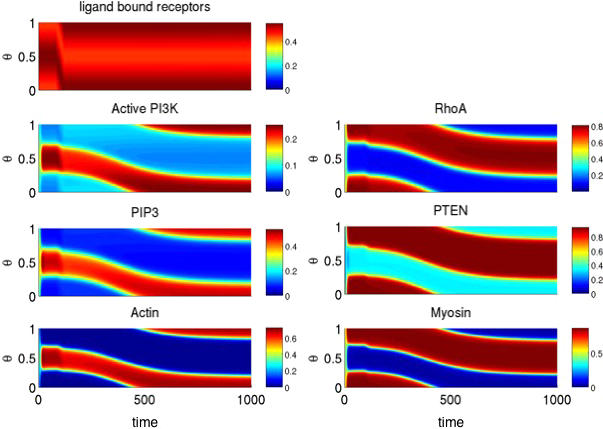
Separation of Front and Back Molecules in Response to a 50% Gradient of ChemoattractantSpatial and temporal distribution of the front (left) and back (right) signaling molecules. The abscissa is time (dimensionless), the ordinate θ, taking values between zero and one, is the position on the membrane, and the color intensity denotes the concentration. Chemoattractant concentration on the surface of the cell was specified by the function L(θ) = 1 − 0.25 cos(2πθ). The gradient direction rotates by 180° from t = 80 − 120. One dimensionless time unit corresponds roughly to 0.05 s in real time [53].